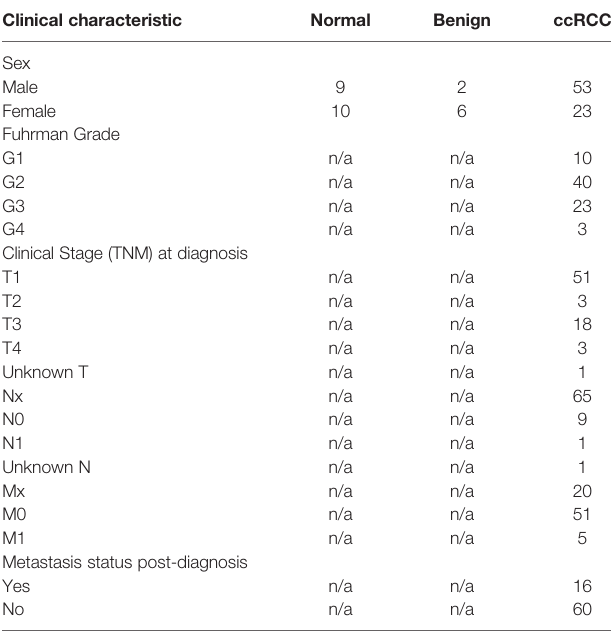
TABLE 1 | Summary of cohort clinical